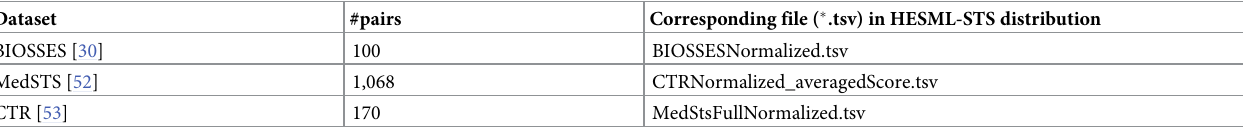
Table 1. Benchmarks on biomedical sentence similarity evaluated in this